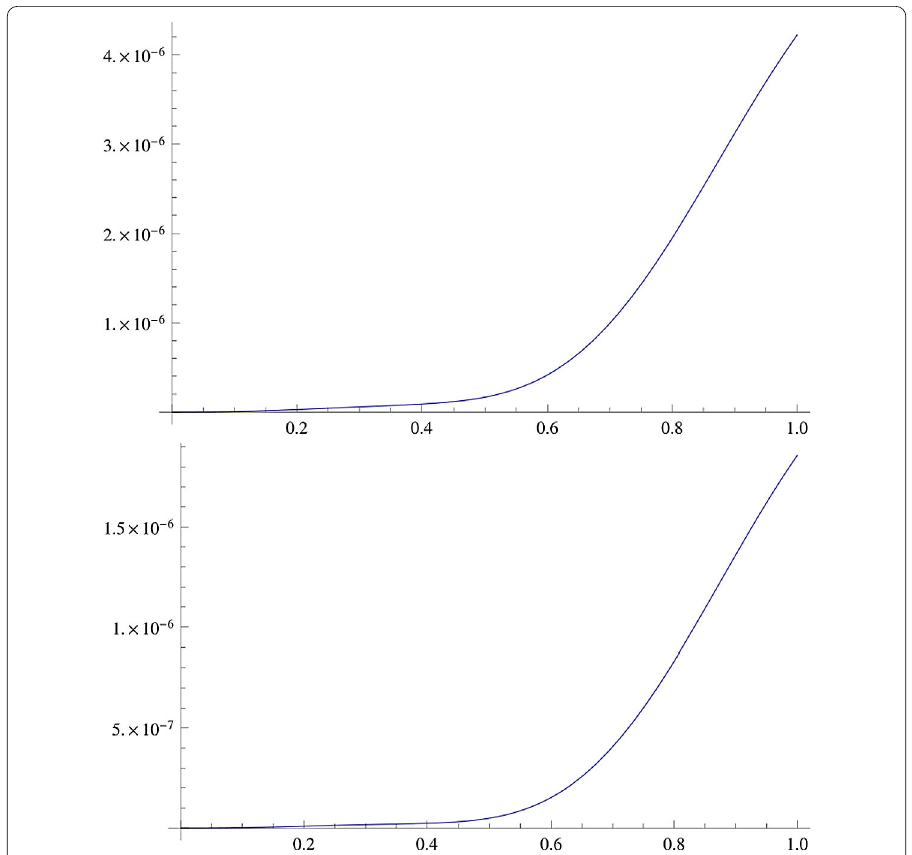
Figure 5 Figures of absolute errors | u ( x ) – u 30 5 | , | u ( x ) – u 45 5 | for Example 5